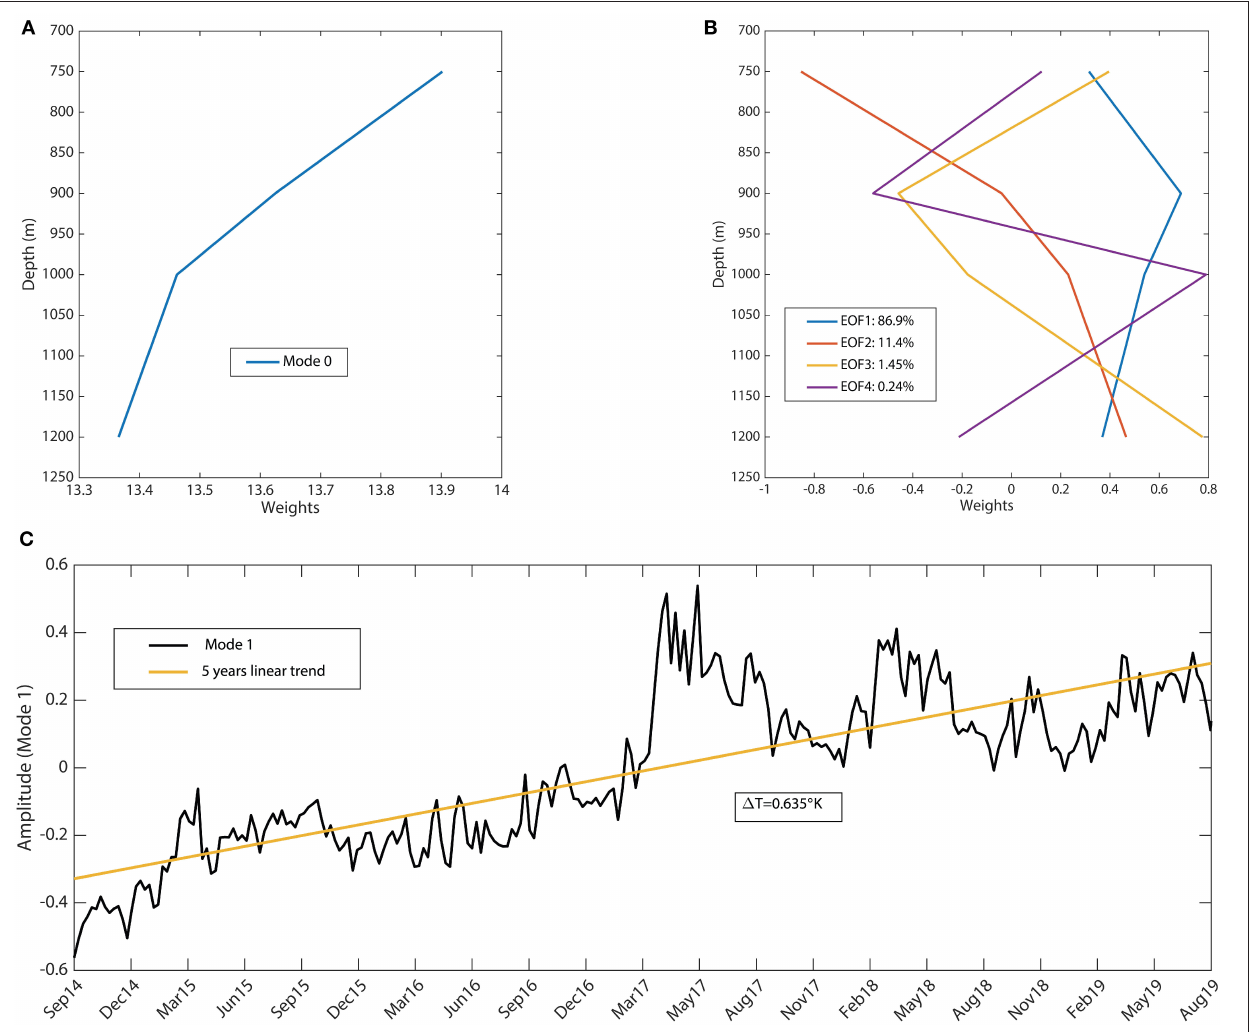
FIGURE 6 | Temporal average of data, EOF mode 0 (A) and the EOF modes 1 to 4 with their variances given in the legend (B) . Temporal evolution of the amplitude of EOF mode 1 (C)